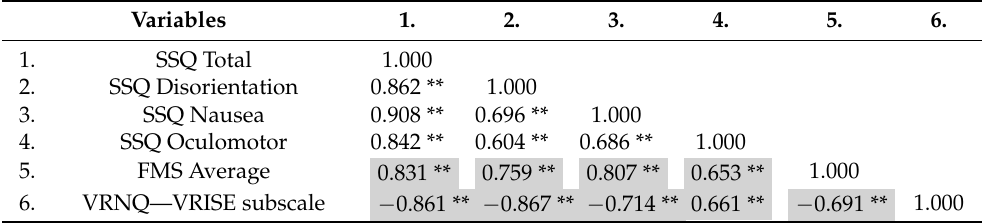
Table 7. Correlation matrix for HA_NORF condition—Spearman ( ρ ) correlation coefficients for combined VRISE measures ( n = 6).